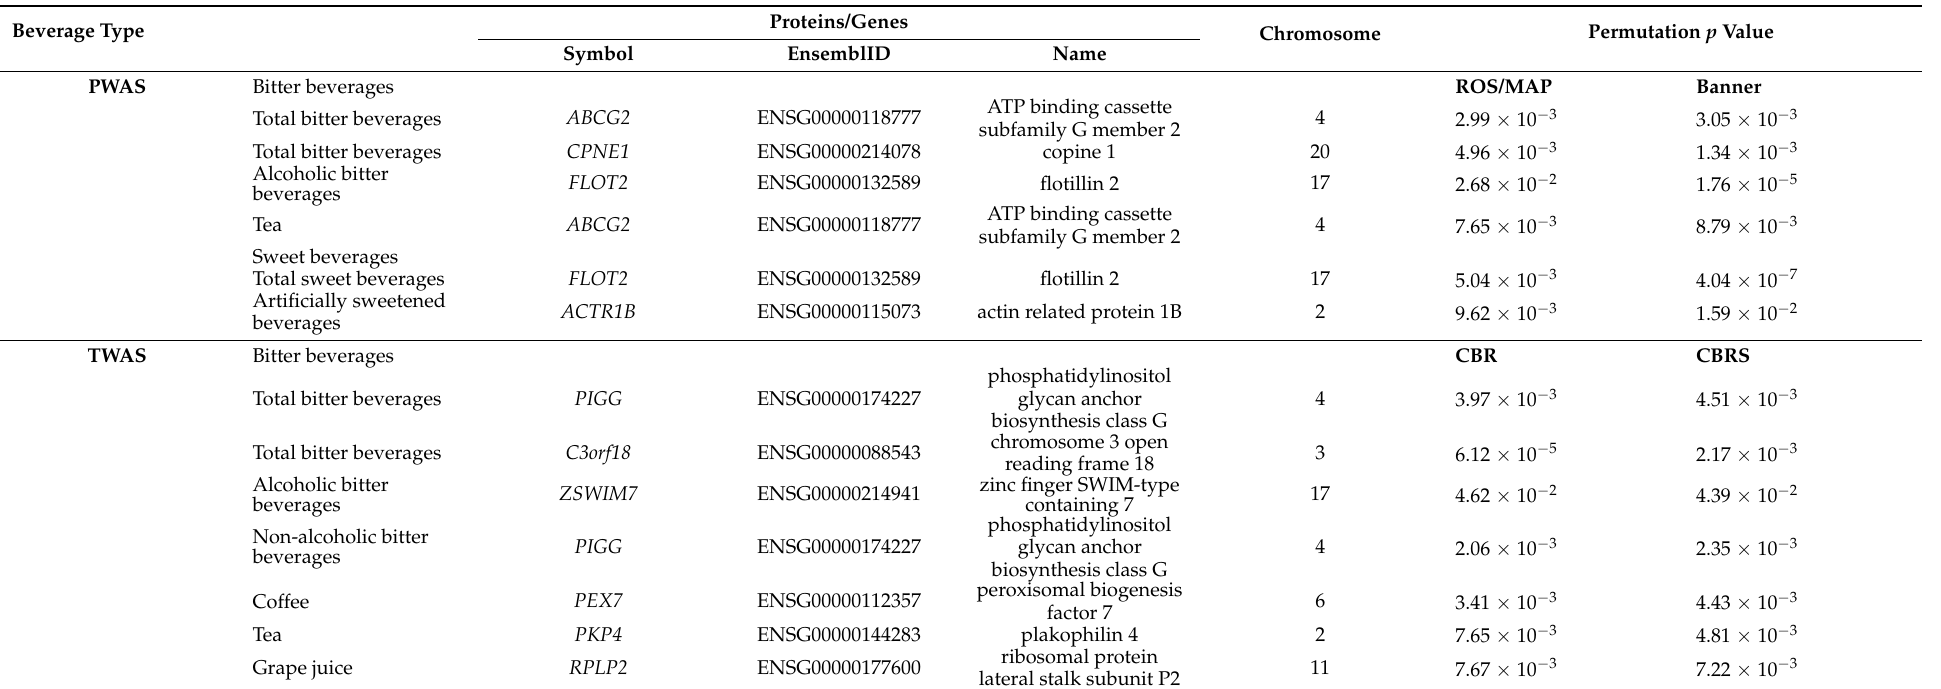
Table 1. Significant proteins or genes identified by PWAS and TWAS analysis for beverage